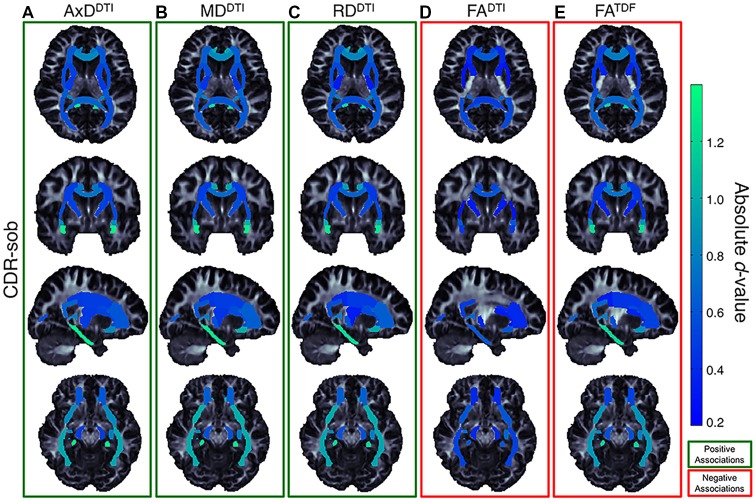
Effect size (absolute d-value) maps of WM regions that show significant associations with CDR-sob—the cognitive measure with the largest effect sizes—reveal widespread associations throughout the WM, with particularly strong associations in the temporal lobes (SS, IFO, UNC, and CGH; light green regions show the largest effect sizes). As expected, positive associations were detected between CDR-sob and (A) AxDDTI (FDR critical threshold p = 1.78 × 10−4; B) MDDTI (FDR critical threshold p = 3.64 × 10−4) and (C) RDDTI (FDR critical threshold p = 6.92 × 10−3); higher diffusivity was associated with greater cognitive impairment. Lower (D) FADTI (FDR critical threshold p = 0.025) and (E) FATDF (FDR critical threshold p = 7.73 × 10−3) were also associated with greater impairment, but FADTI associations were detected in fewer regions with weaker effect sizes compared to FATDF.